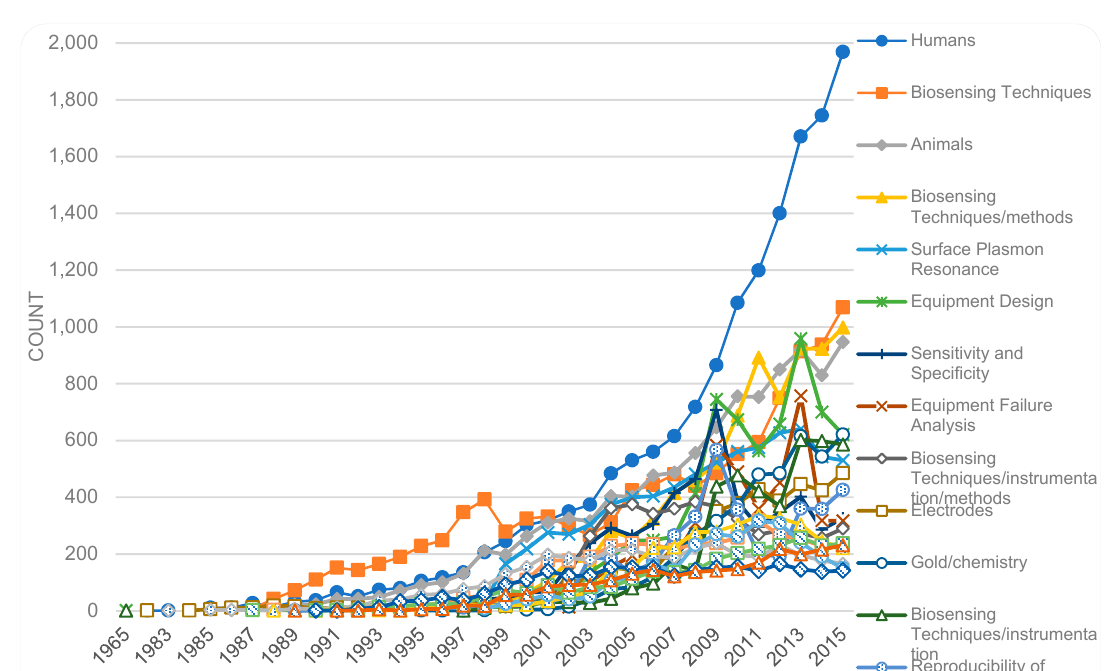
Figure 17. MeSH terms (top 20).